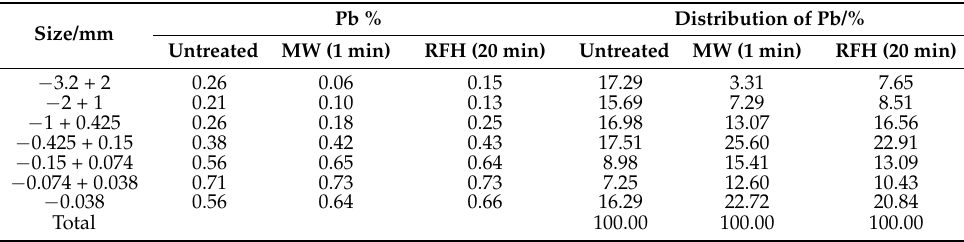
Table 8. Grade and distribution of Pb for each particle size range of the grinding product.